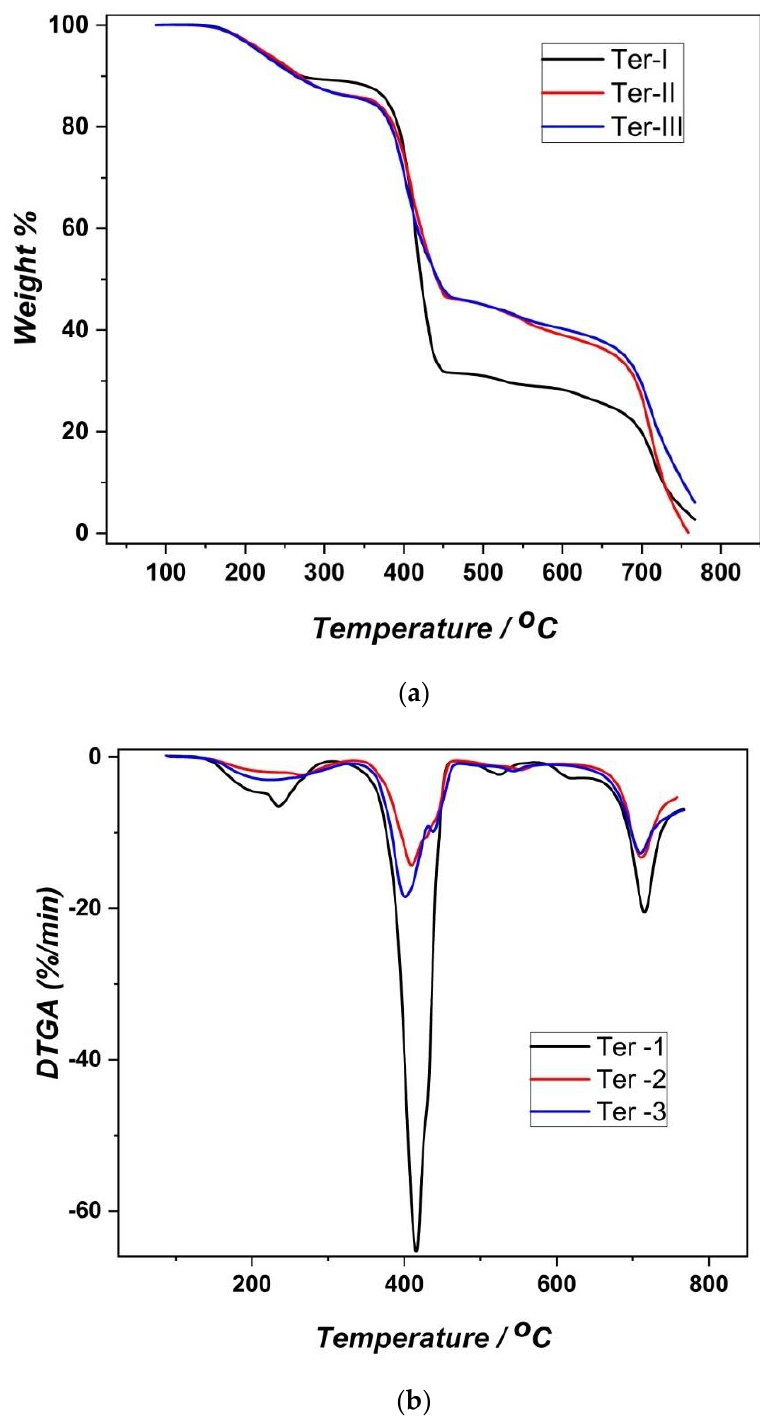
Figure 2. ( a ) TG measurements and ( b ) DTGA results of the three terpolymer samples at a 10 °C/min heating rate.